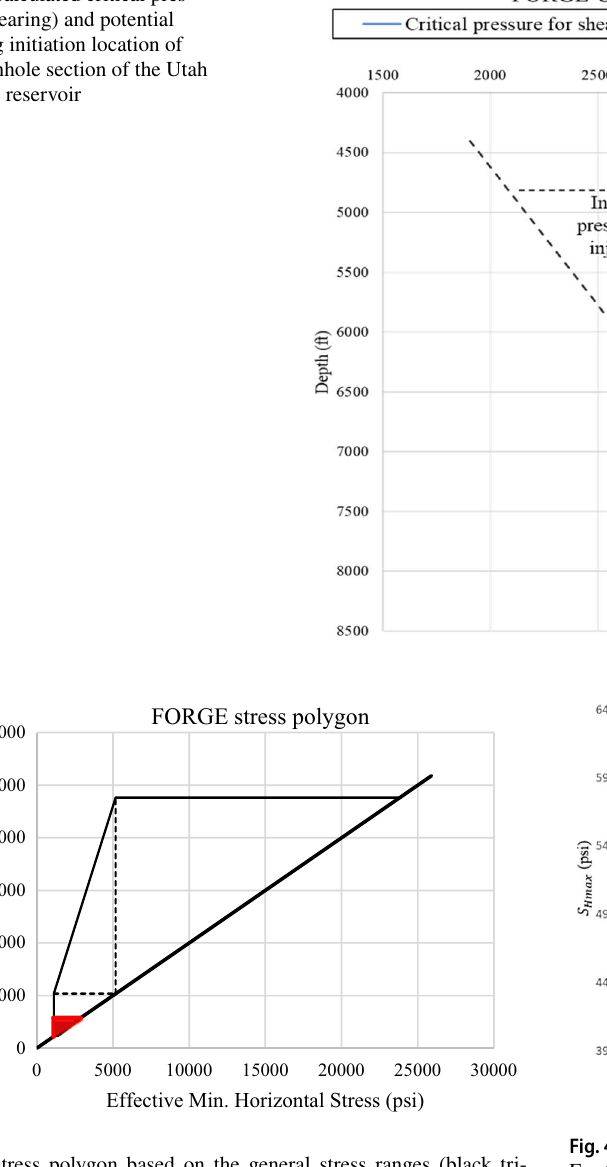
Fig. 3 Stress polygon based on the general stress ranges (black tri- angle). The red triangle shows the stress regime in the FORGE res- ervoir. The stress limits are computed using a friction coefficient of 0.82